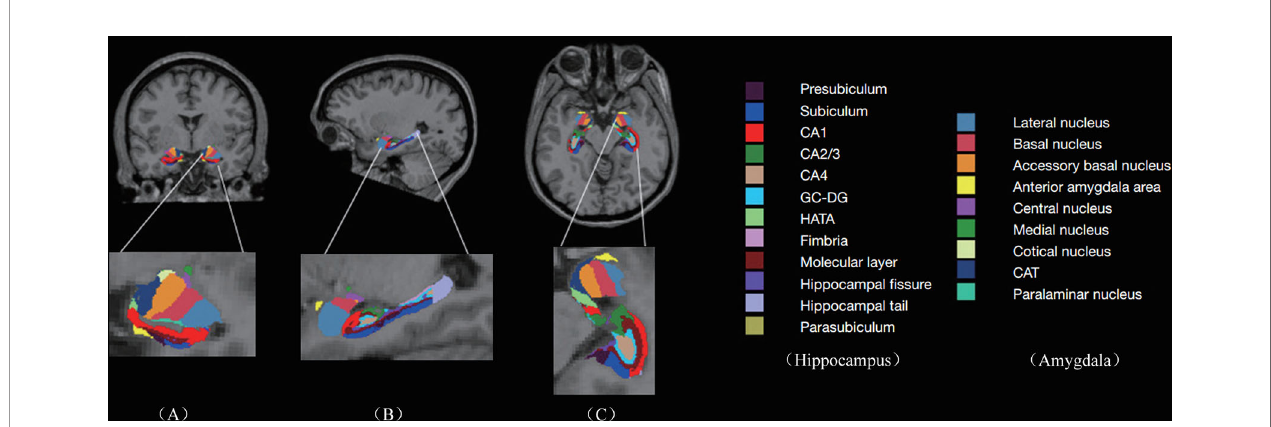
FIGURE 1 | Subregions of hippocampus and amygdala: Columns (A – C) represent the image view of coronal, sagittal, and axial, respectively. The second row represents the enlarged subregions on the left. CA, cornus ammonis; GC-DG, granule cell layer of the dentate gyrus; HATA, hippocampal amygdala transition area; CAT, cortico-amygdaloid